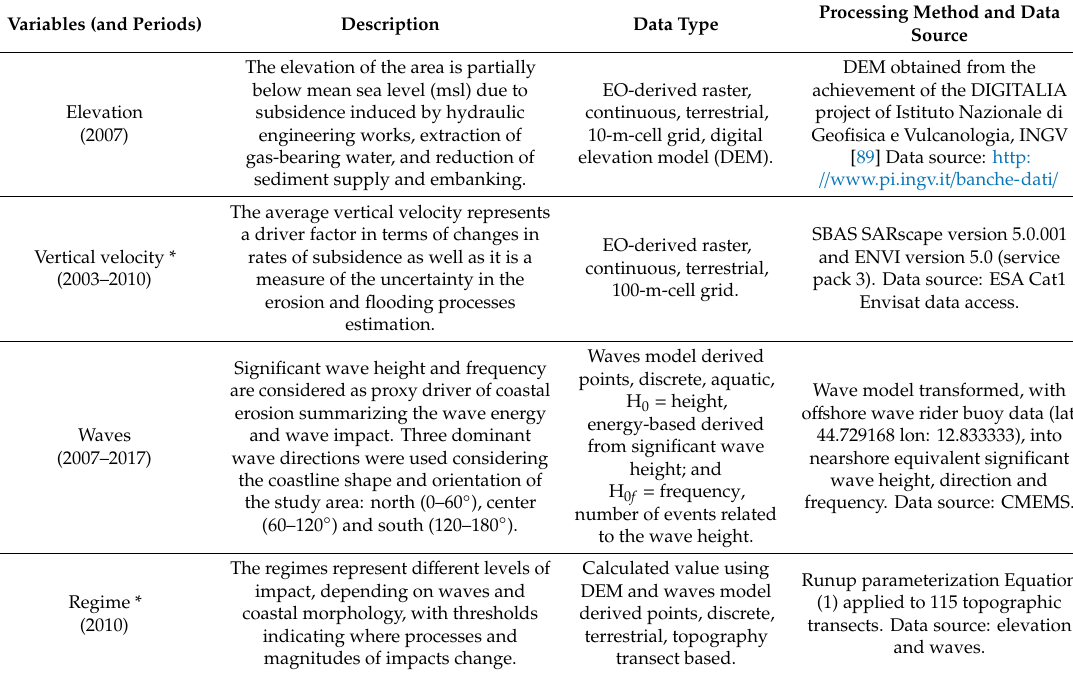
Table 1. List of input variables used in the Bayesian belief network (BBN) and